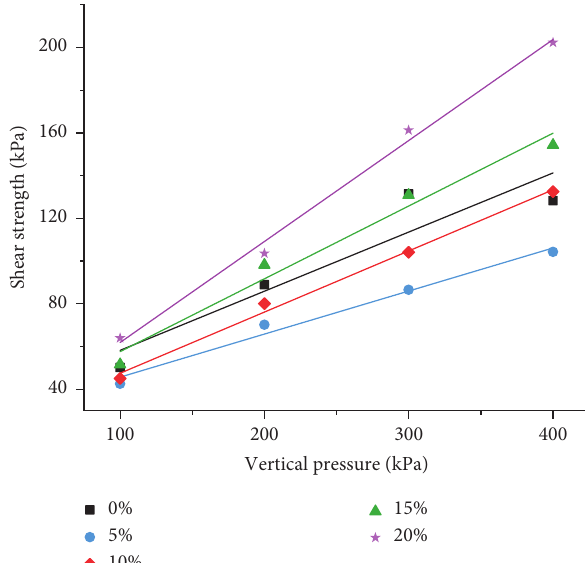
Figure 2: Shear strength of red clay samples with different calcium carbonate contents.